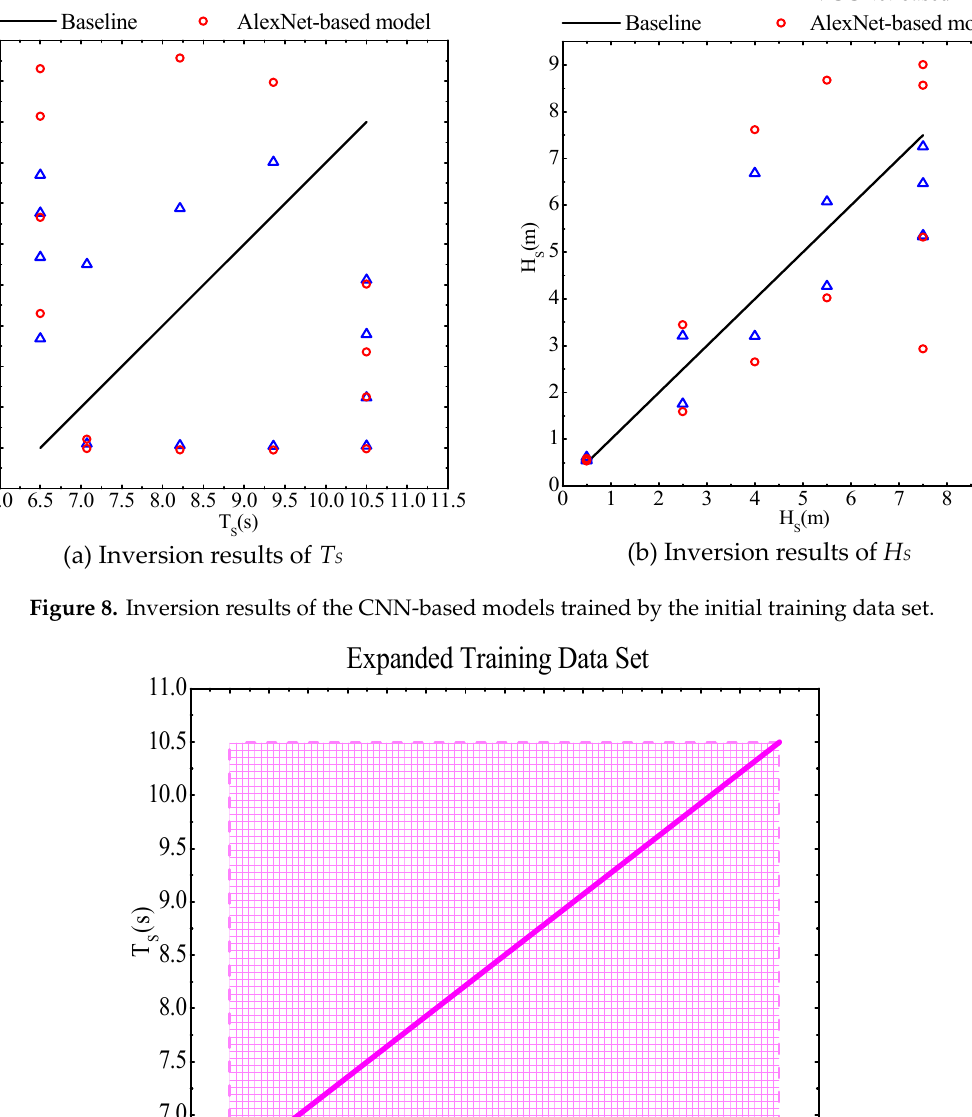
Figure 7. Examples of the test sample images.